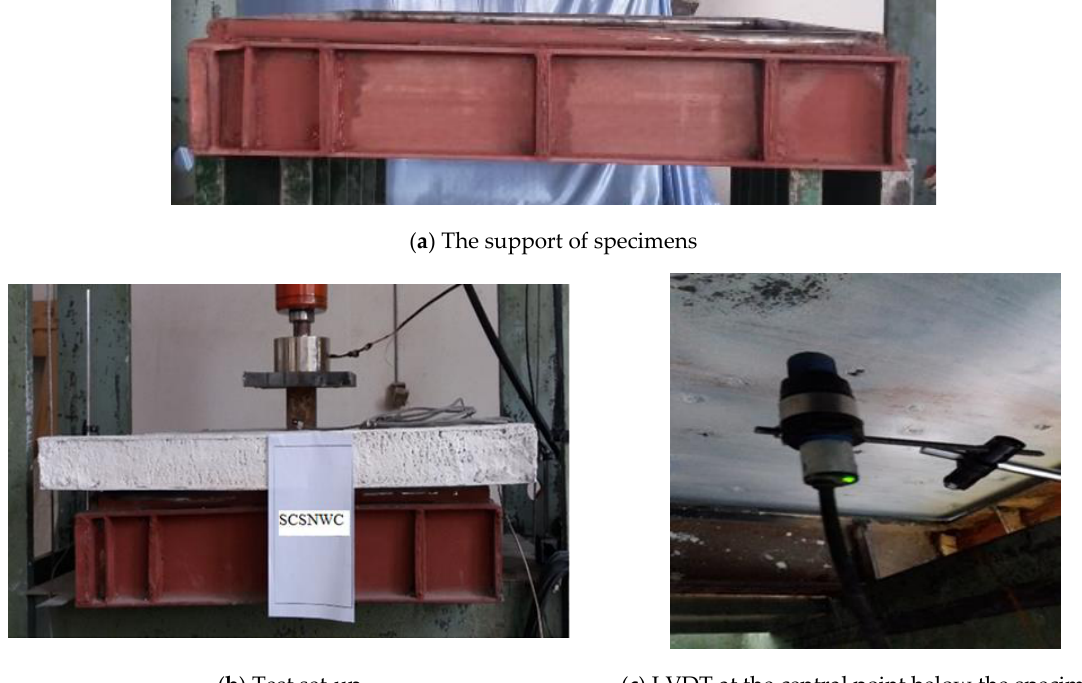
Figure 10. SCS sandwich slab under quasi-static load.